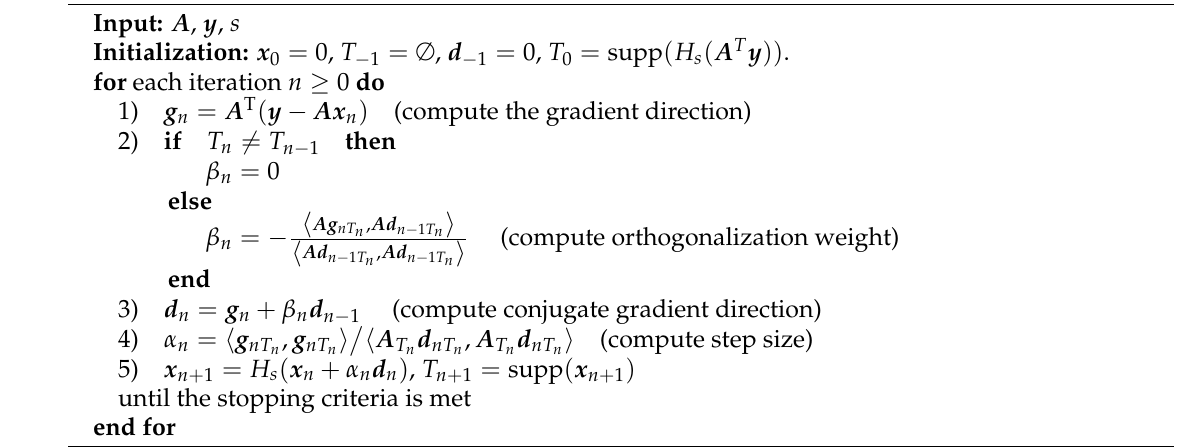
Algorithm 2 [19] Conjugate Gradient Iterative Hard Thresholding restarted for Compressed Sensing Input: A , y ,